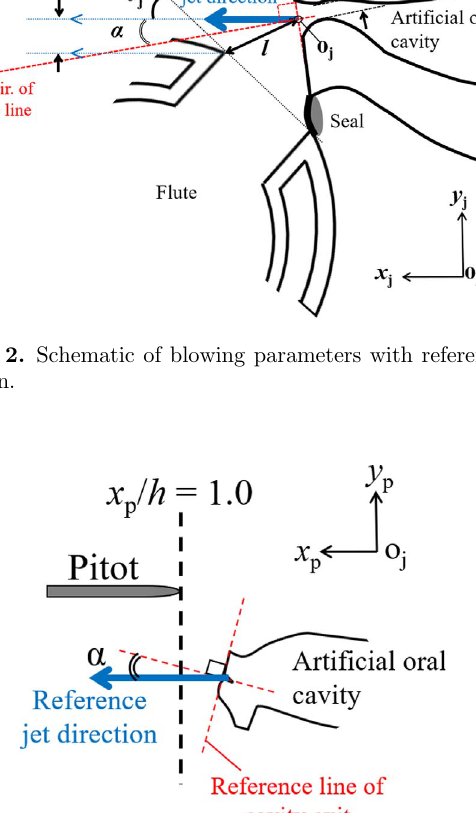
Figure 3. Measurement for reference jet direction.